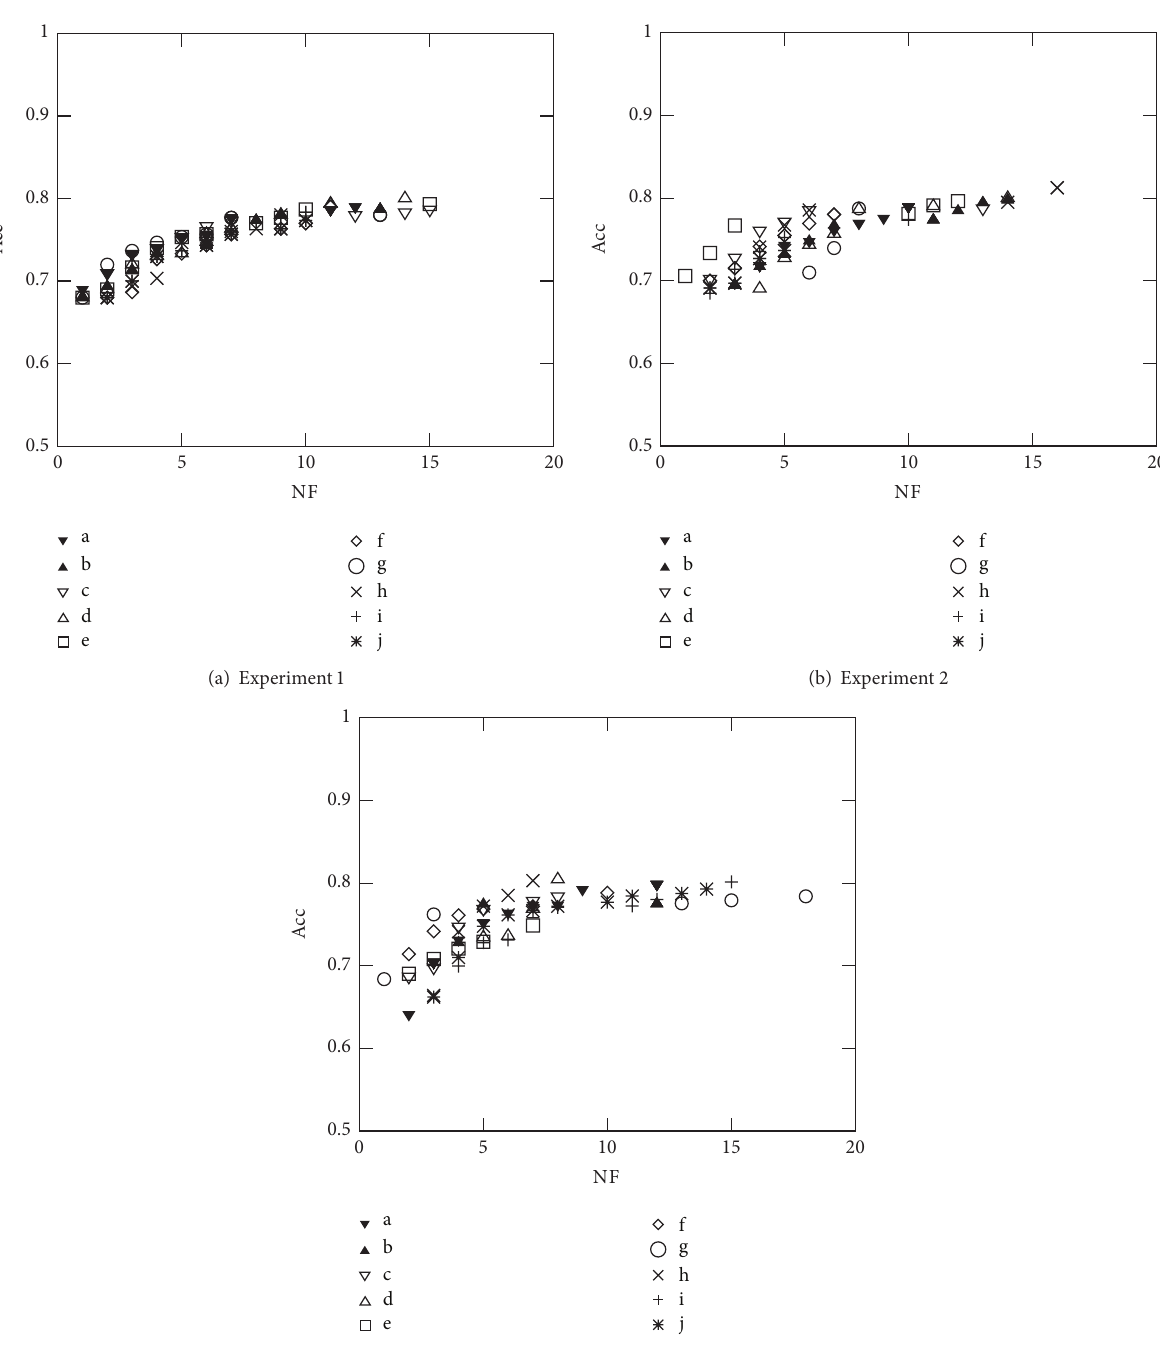
Figure 9: Optimal Pareto fronts for German Credit data (10